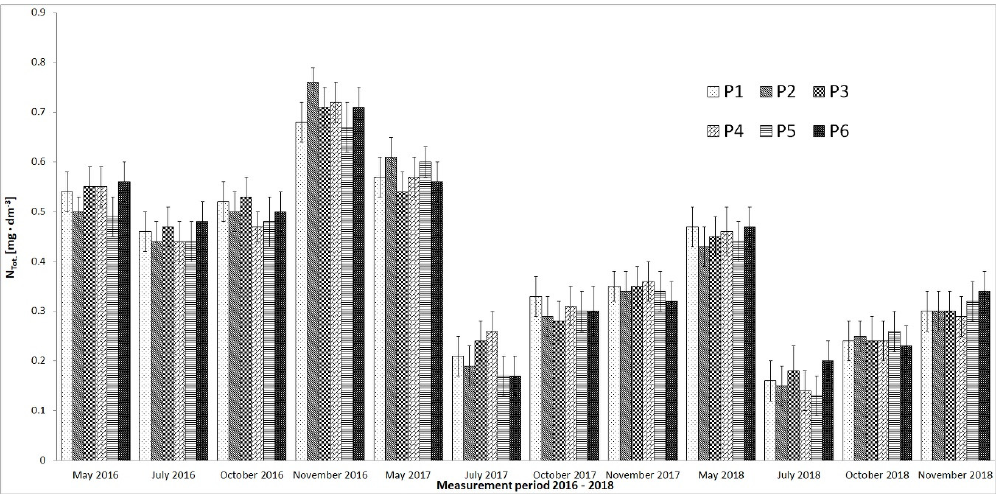
Figure 9. Changes in N tot value at points P1–P6 in the reservoir. Measurement campaigns 2016–2018.